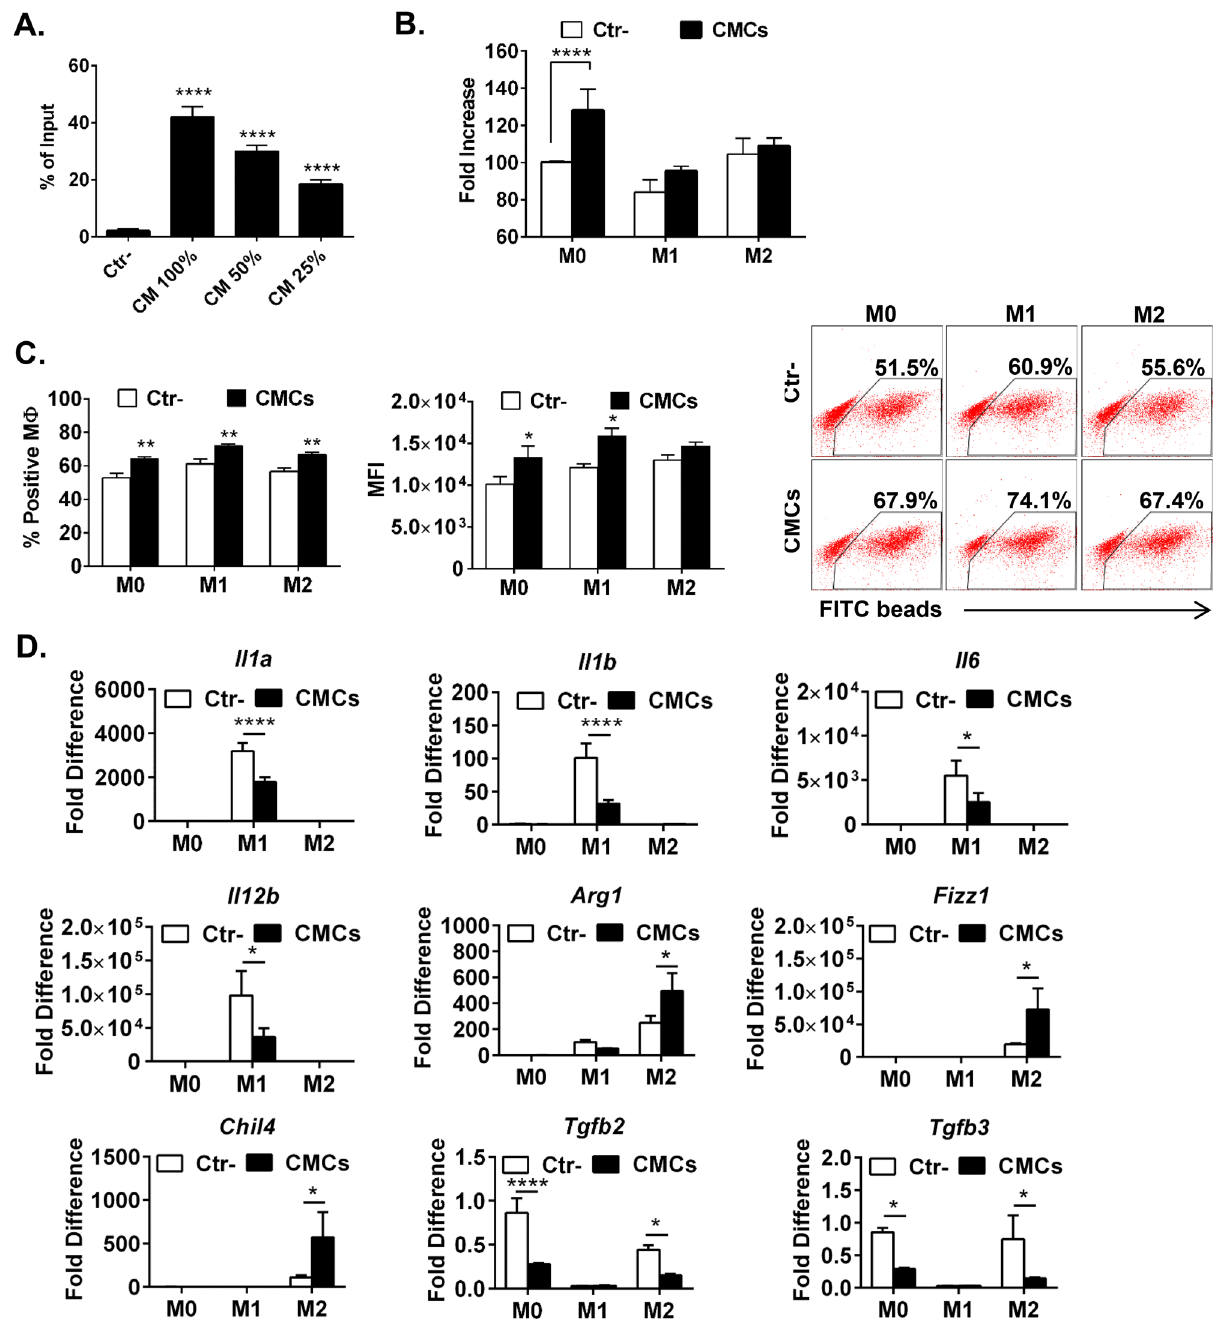
Figure 4. CMC secretome increases monocyte migration and macrophage proliferation, phagocytosis, and inhibits pro-inflammatory activation in vitro. Bone marrow monocytes were subjected to migration assay with modified Boyden chamber plates to CMC conditioned media. Number of migrated cells shown as mean ± SEM; n = 4; **** P < 0.0001 ( one-way ANOVA ) ( A ) . Naïve bone marrow macrophages (M0) were stimulated with LPS (100 ng/mL) and IFNγ (20 ng/mL) (M1), or IL-4 (10 ng/mL) and IL-13 (10 ng/mL) in the precence CMC conditioned media or control media. After 24 h macrophage number was evaluated with microscopy ( B ); phagocytosis of FITC IgG opsonized latex beads was determined with flow cytometry ( C ), and expression of pro-inflammatory gene expression was quantified with qPCR ( D ). Data are means ± SEM; n = 6; * P < 0.05; ** P < 0.01; **** P < 0.0001 ( one-way ANOVA